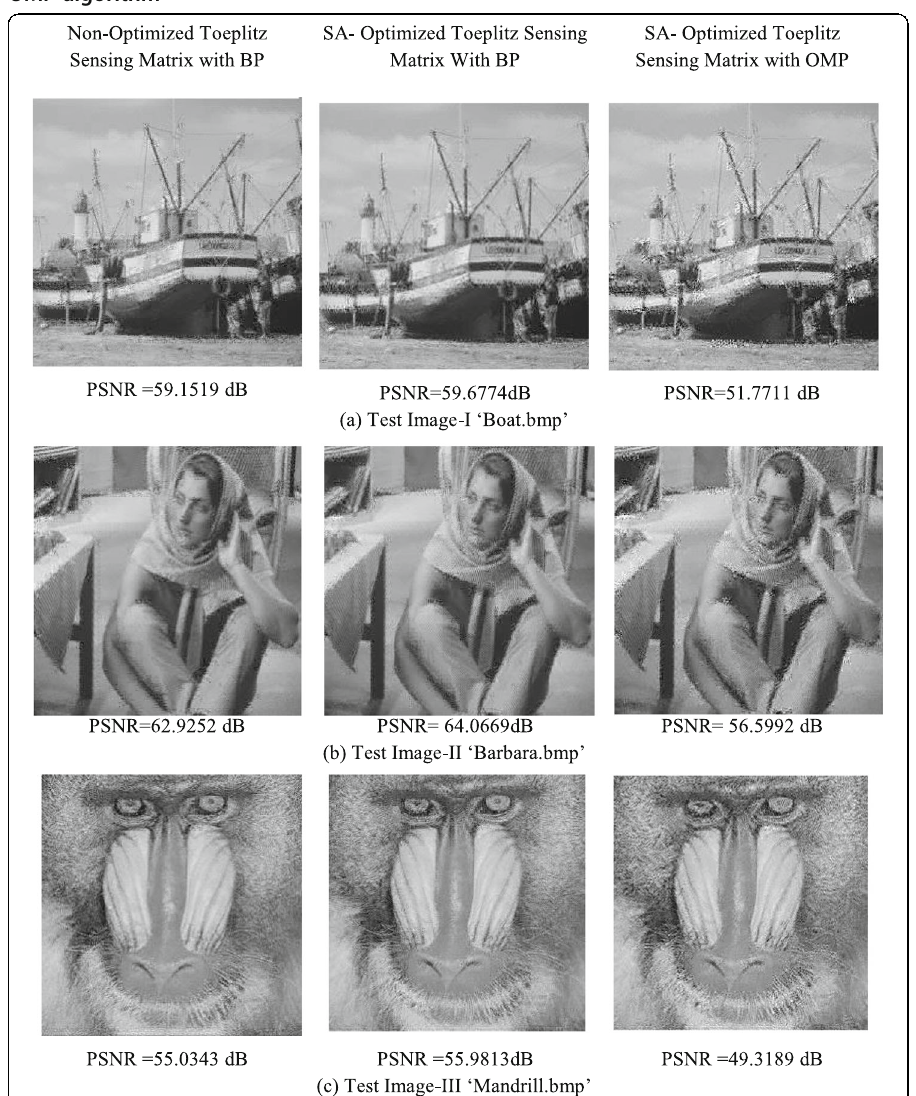
Fig. 17 Comparison between reconstructed test images using the proposed SA-optimized sensing matrix with BP and OMP algorithm for CR=0.5. a Test Image-I “ Boat.bmp. ” b Test Image-II “ Barbara.bmp. ” c Test Image-III “ Mandrill.bmp